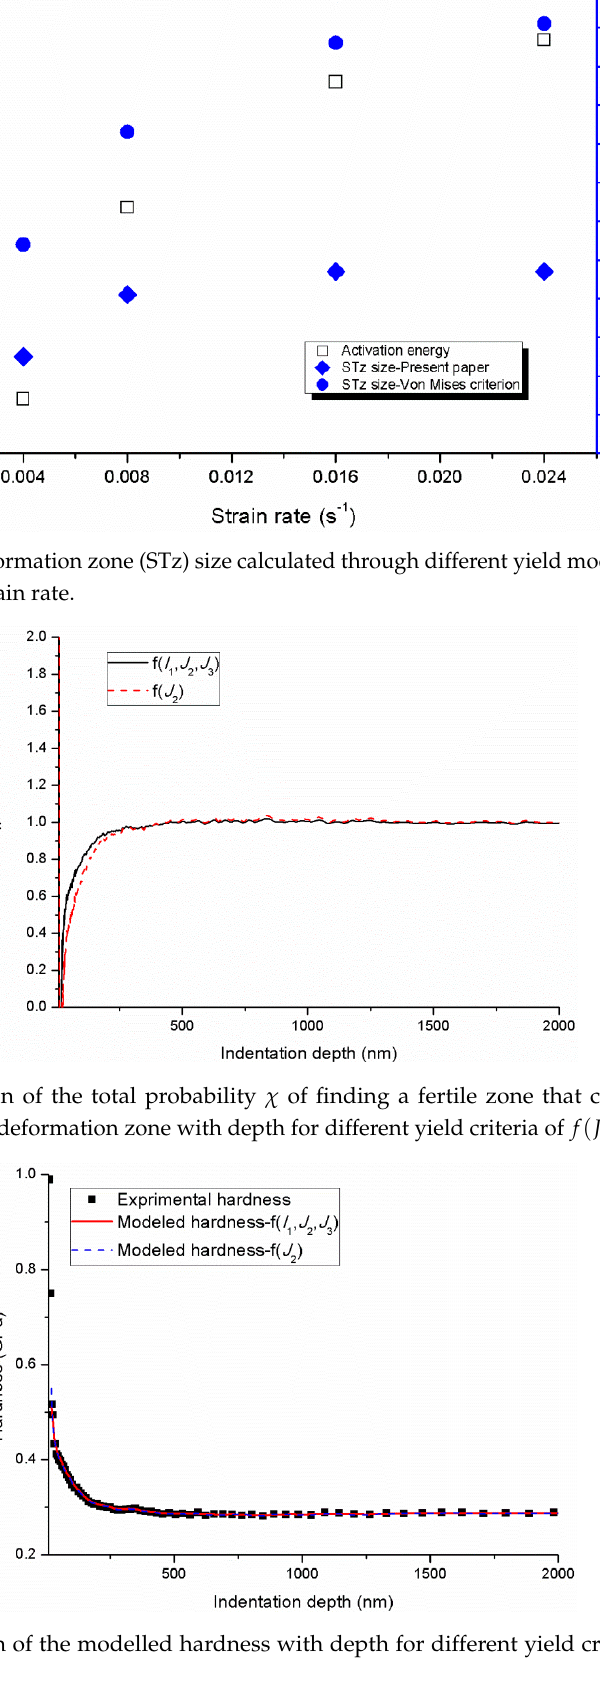
Figure 9. Comparison of the modelled hardness with depth for different yield criteria of f ( J 2 ) and f ( I 1 , J 2 , J 3 ) .